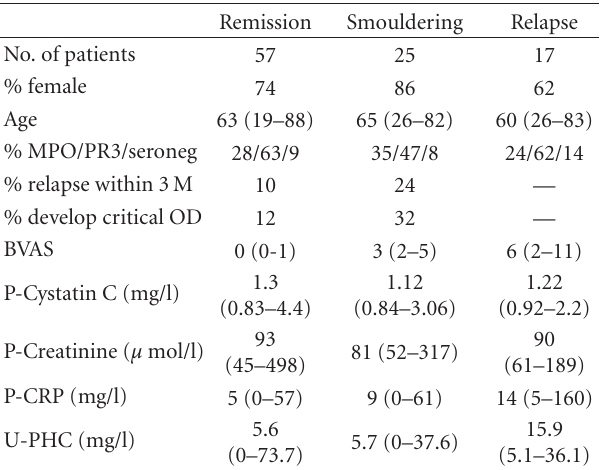
Table 1: Patient